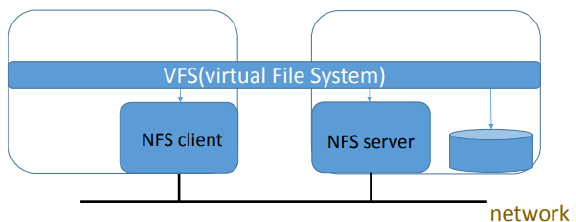
Figure 2. Illustration of NFS o ff ering a shared view of vitual file system to client and